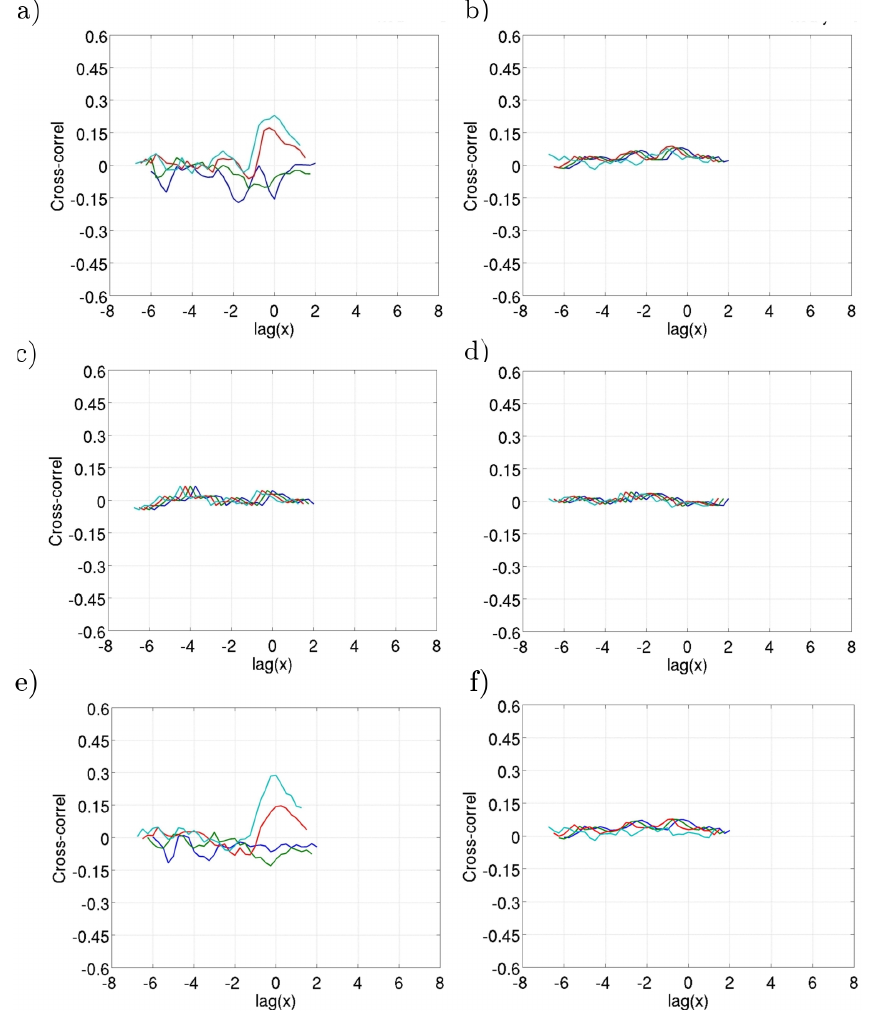
Fig. 8. Y − C cross correlation at t =4 T for the nodes located at y =5.75 L in scenario 1a (a) , scenario 1b (b) , scenario 3a (c) , scenario 3b (d) , scenario 4a (e) , and scenario 4b (f) . Each color corresponds to a correlation structure centered at a different node sampled by the plume (see Figure 2, subpanel b)